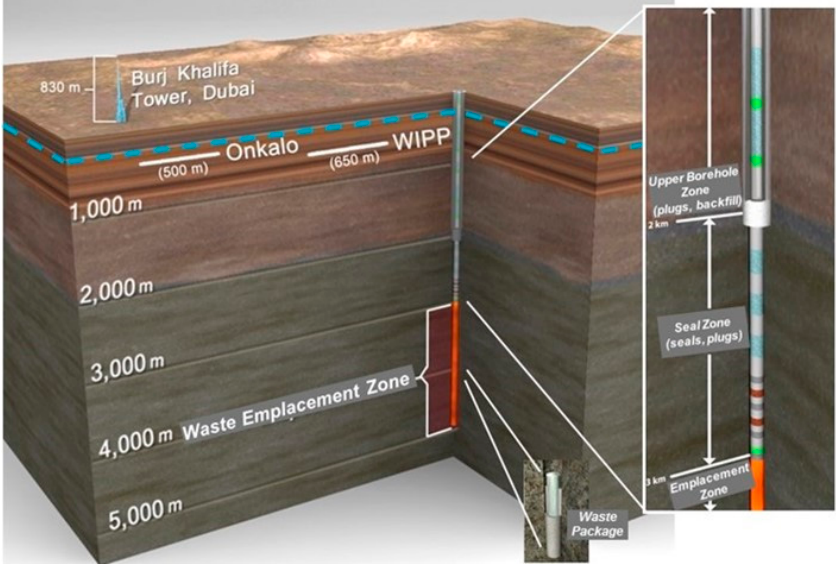
Figure 1. Generalized schematic of the deep borehole disposal (DBD) concept. WIPP: waste isolation pilot plant.